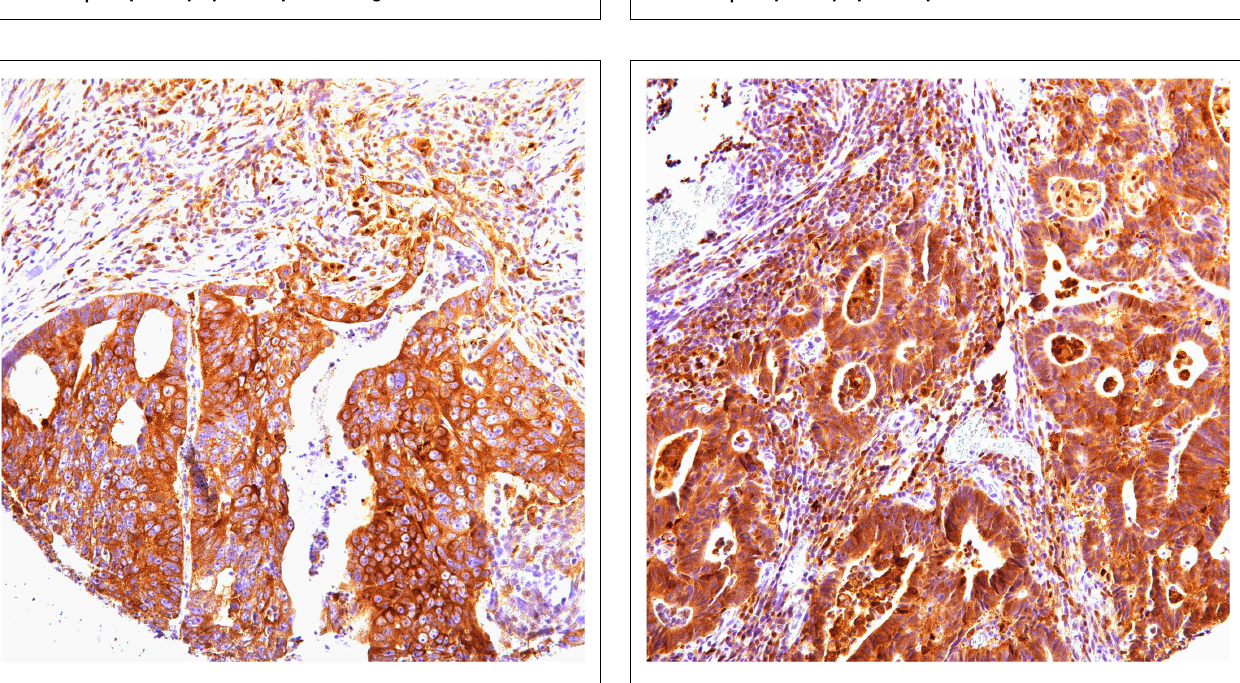
FIGURE 1 | Ubiquitin cytoplasmic positive in gastric carcinoma .